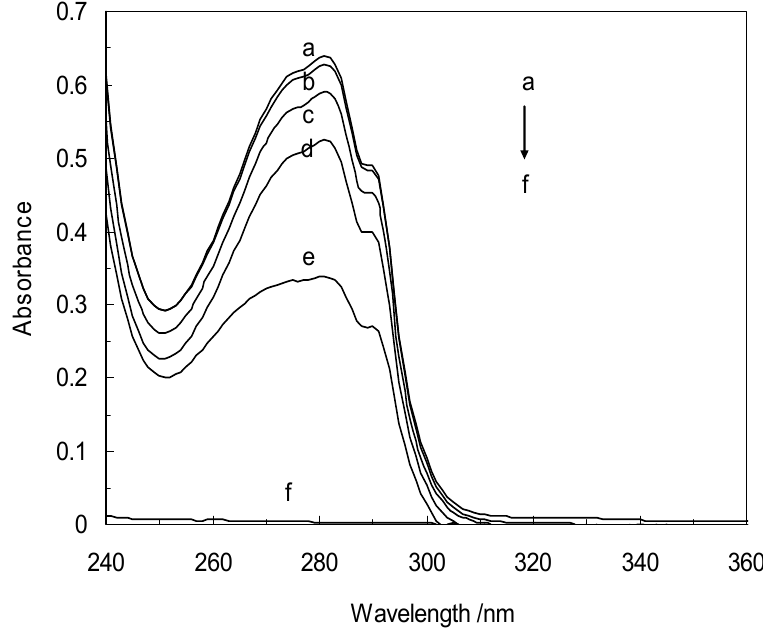
Figure 3. UV/vis absorbance spectra of: a : LYZ-CYC; b : [LYZ-CD( α )]CYC; c : LYZ; d : [LYZ-CD( γ )]CYC; e : [LYZ-CD( β )]CYC; f : CYC, in pH = 7.4 and T = 298 K. − 6 mM and [CDs] = 0.04 mM in all [CYC] = 3.5  10